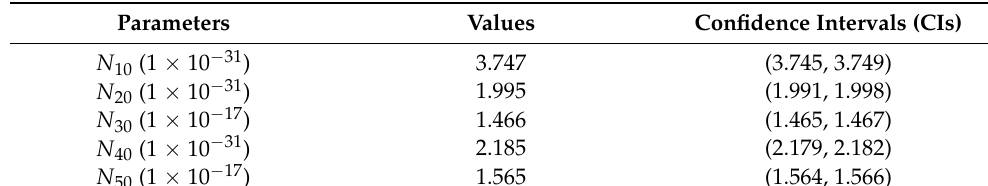
Table 1. The fitted constant N i 0 and the corresponding confidence interval for 3 nm GAA nanosheet under V gs = − 0.65 V, V ds = 0 V.